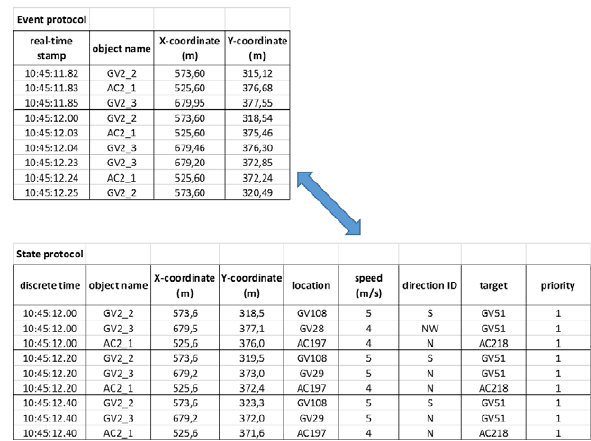
Figure 5. Bidirectional transformation of state and event